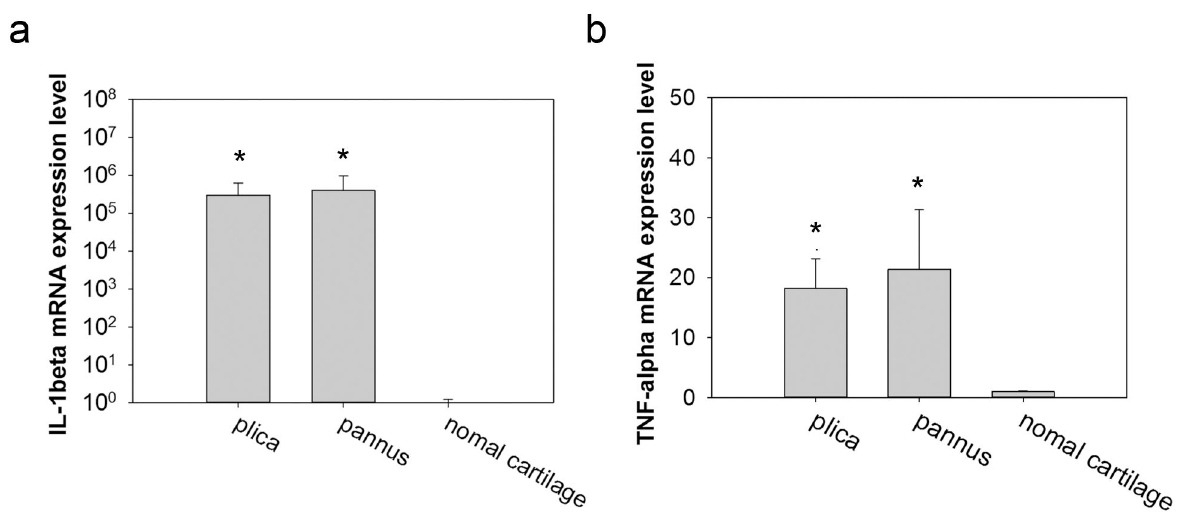
Figure 4. IL-1β and TNF-α mRNA levels in the medial plica and pannus-like tissue in stage IV OA knees and normal cartilage. Real-time polymerase chain reaction analysis of IL-1β (left panel) and TNF-α (right panel) mRNA levels in the medial plica and pannus-like tissue in stage IV osteoarthritis knees and normal cartilage expressed relative to levels in normal cartilage. Each bar represents the mean ± standard deviation for 15 samples. * P < 0.05.